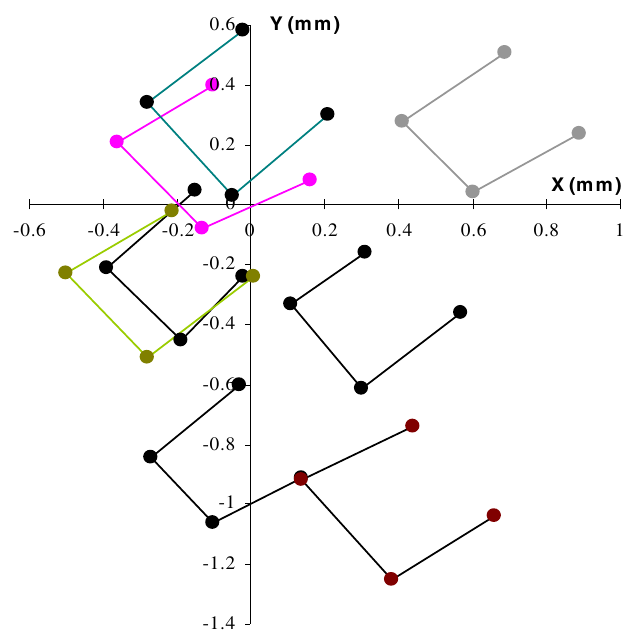
FIG. 21. (Color) Comparison of X and Y position measurements FIG. 19. (Color) Total offset measured with eight different LR- for the fake block (F.B.) and the BPM block mounted on the test BPM electronics channels. Each dot corresponds to one mea- stand. The responses are given versus the sum from the four surement. The cable ends at the side of the BPM are permuted 4 electrodes. We observe an intensity dependence for the X and Y times. The red vector corresponds to the intrinsic offset and the Þ associated to the ; (cid:2) y displacement values due to the limitations of the logarithmic blue vector corresponds to the offset ð (cid:2) x c c cables and the amplifier in the readout electronics.